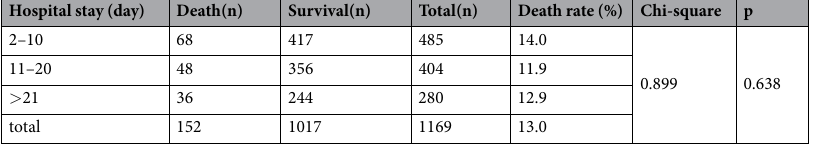
Table 2. Relationship between length of hospital stay and 90-day mortality rate in patients with acute kidney